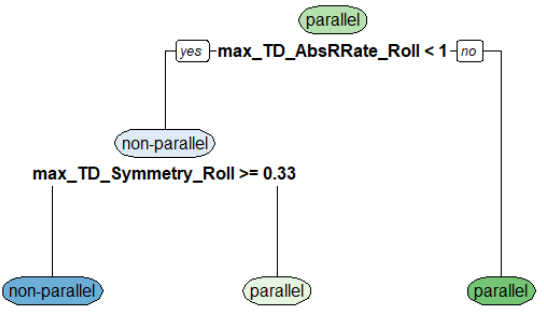
Figure 7. Decision tree for pre-classification (max_TD_AbsRate_Roll = maximum absolute roll axis angular velocity, max_TD_Symmetry_Roll = maximum symmetry of the roll axis angular